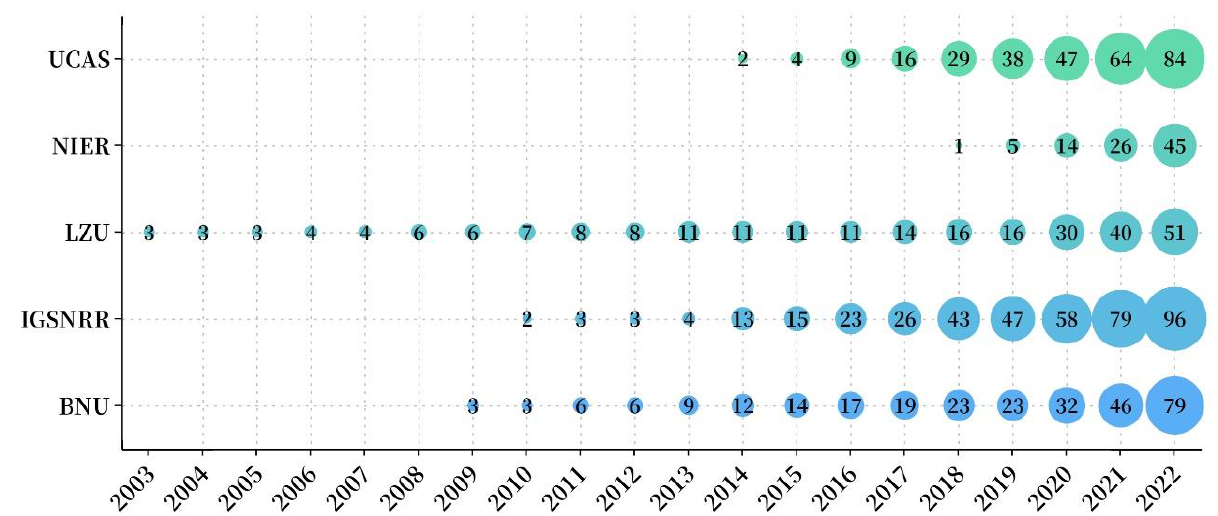
Figure 7. Annual cumulative number of documents issued by the top five institutions in the field of studying the ecological and environmental effects of land use and cover changes (LUCC) on the Qinghai-Tibetan Plateau (QTP). Note: UCAS = University of Chinese Academy of Sciences, NIER =